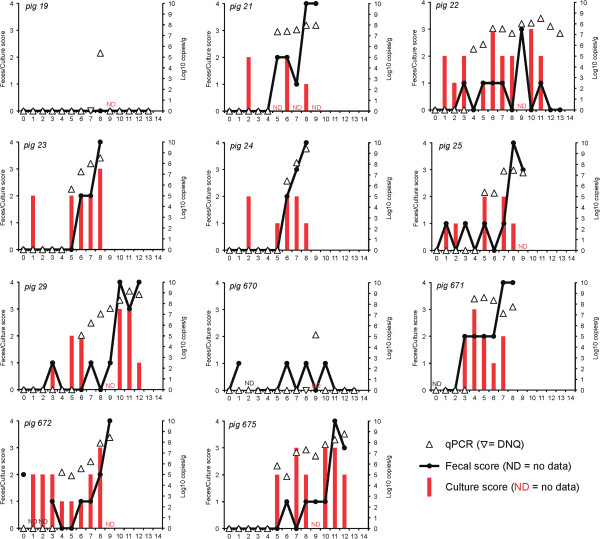
Fecal consistency scores, culture results and fecal concentration of “Brachyspira hampsonii” strain 30599 following inoculation. Fecal consistency scores (line, left ordinate: 0 = formed, normal; 1 = soft, wet cement consistency; 2 = runny or watery; 3 = mucoid diarrhea; or 4 = bloody diarrhea), semi-quantitative fecal culture score (red bars, left ordinate: 0 = negative; 1 = less than 10 colonies/1° streak; 2 = less than 10 colonies/2° streak; 3 = less than 10 colonies/3°streak; 4 = less than 10 colonies/4° streak), and strain 30599 DNA concentration in feces (triangles, right ordinate; upside down triangles indicate DNQ) are shown. Days post-inoculation are shown on the abscissa. ND = no data. Pig IDs are indicated in the upper left corner of each panel.